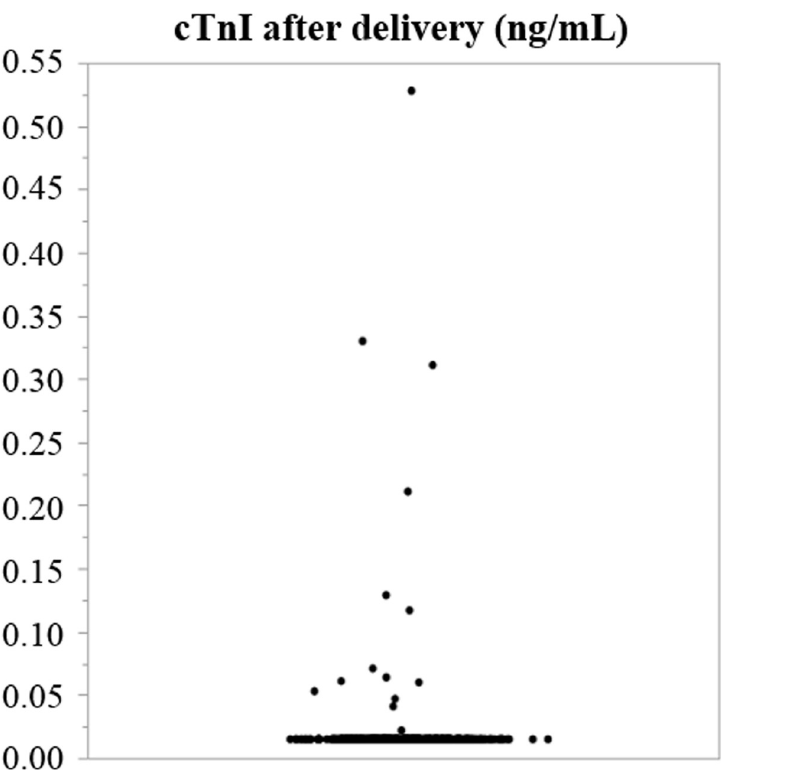
Fig 1. The distribution of cardiac troponin I levels after delivery. cTnI, cardiac troponin I.